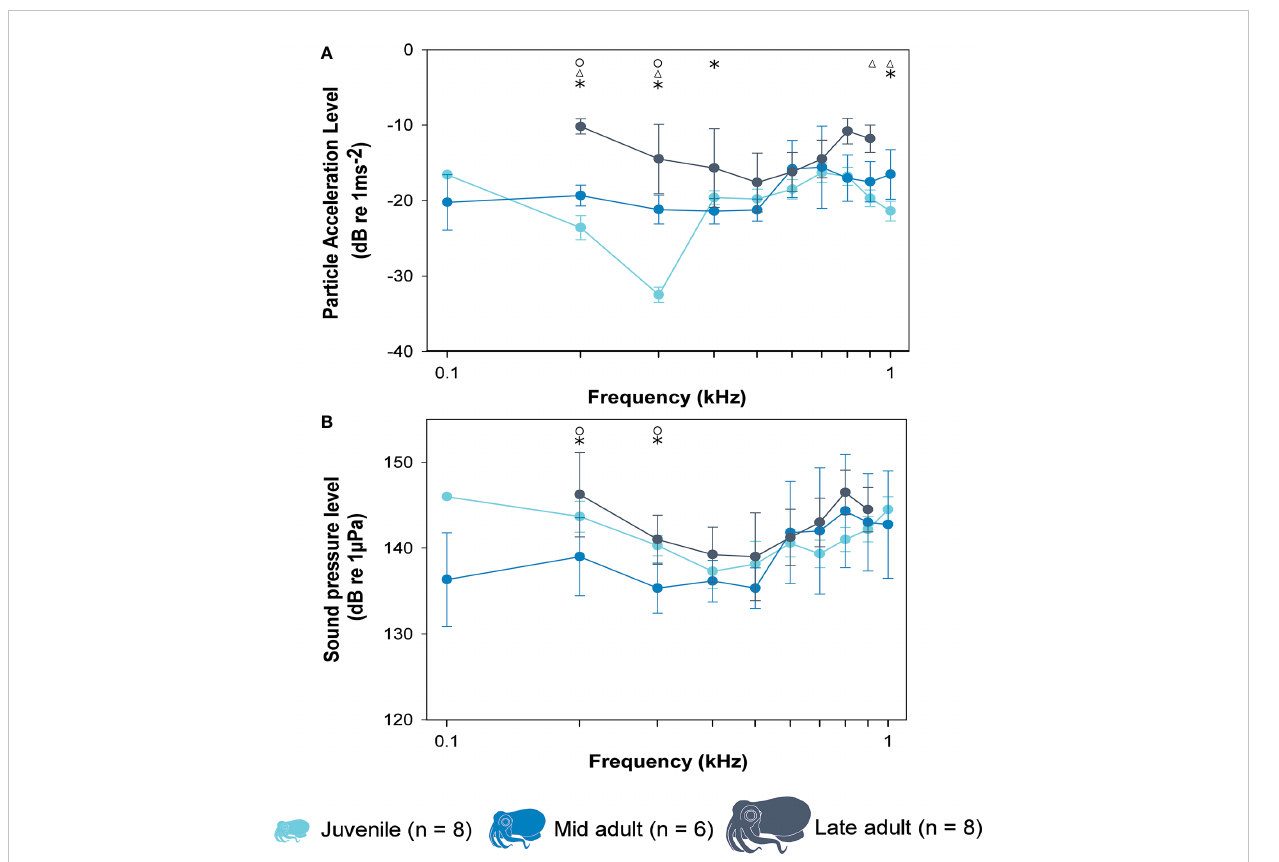
FIGURE 4 The thresholds of (A) particle acceleration level (dB re. 1 ms -2 ) and (B) sound pressure level (dB re. 1 µPa) needed to evoke an AEP response plotted against frequency (Hz) for three different aged hummingbird bobtail squid ( E. berryi ). Data are plotted as mean ± SD. Statistical difference in sensitivity at that frequency indicated by circles (O) between juveniles and mid adults, triangles ( D ) between juvenile and late adult, and asterisks (*) between mid adult and late